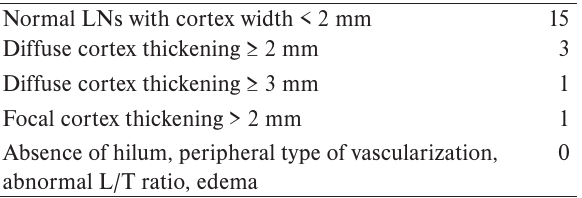
Table 1. The number of positive sentinel node biopsies depending of morphological characteristics of lymph nodes on preoperative ultrasound examination.